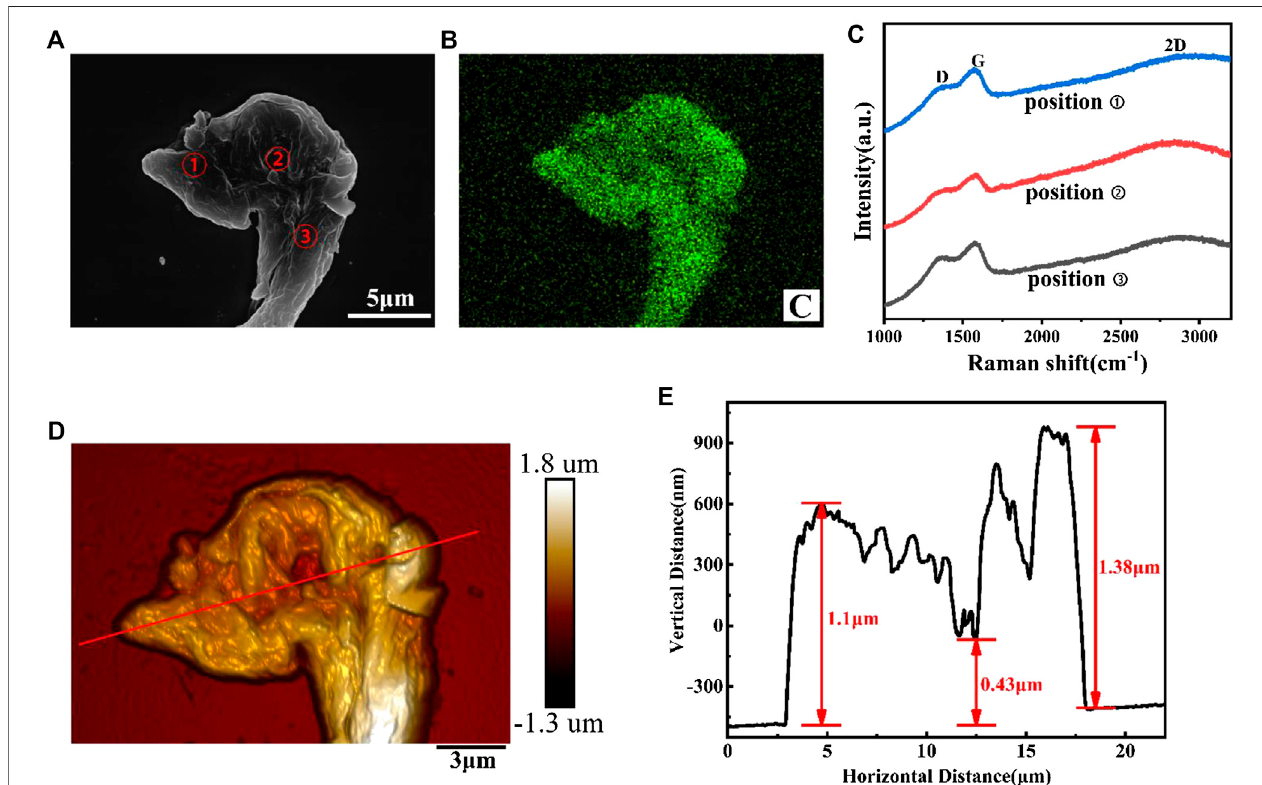
FIGURE 4 | (A) SEM image of the amorphous carbon material on LN (B) EDS mapping for C element in the region shown in (A) (C) Raman Spectra of three positions shown in (A) (D) AFM topographic image of the amorphous carbon material, and (E) AFM height pro fi les along the solid red line in (D) .